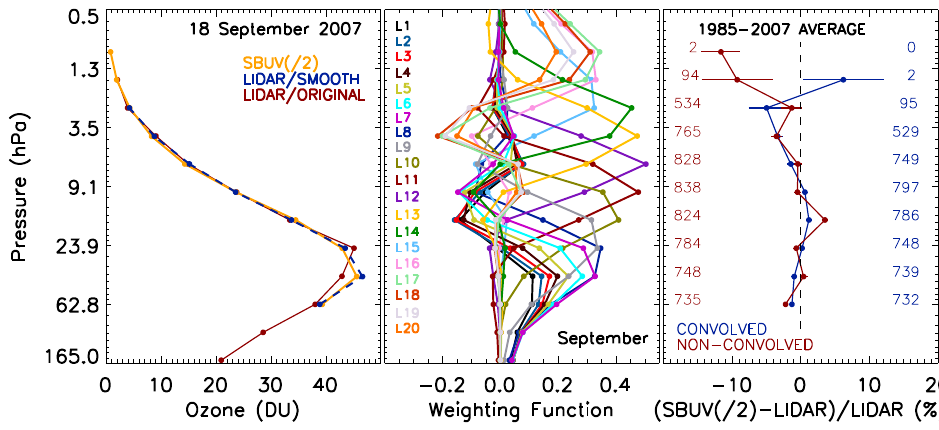
Fig. 2. Left: comparison of lidar measurements, both original and convolved, with SBUV(/2) on 18 September 2007 at OHP. Middle: SBUV(/2) averaging kernels used for convolving lidar data. Right: average relative deviation over the period (1985–2007) between SBUV(/2) and lidar (with and without convolution using averaging kernels and a priori) coincident profiles. The number of analysed profiles with and without convolution are also provided in respective colours. The dashed line represents 0% and the error bars represent twice the standard error.